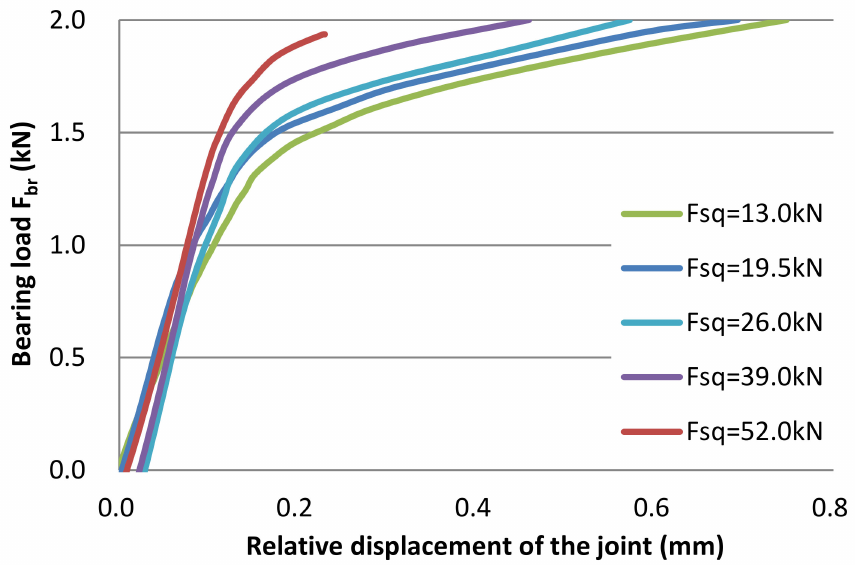
Figure 10. Bearing load–relative displacement curve of the single-row joints.